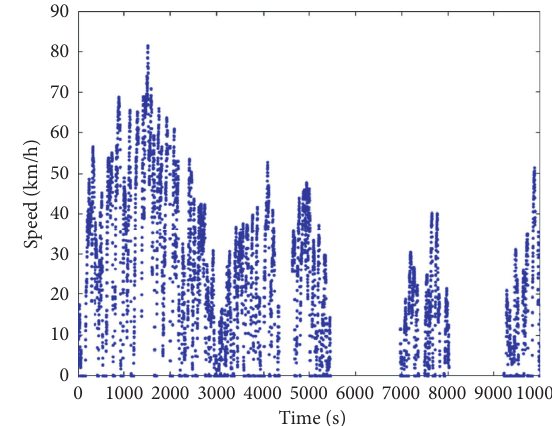
Figure 3: Part of the speed-time